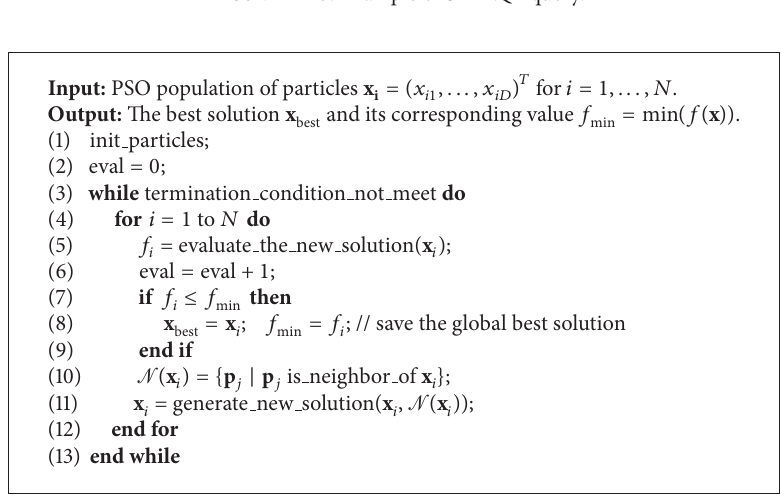
Algorithm 3: Example of SPARQL query.